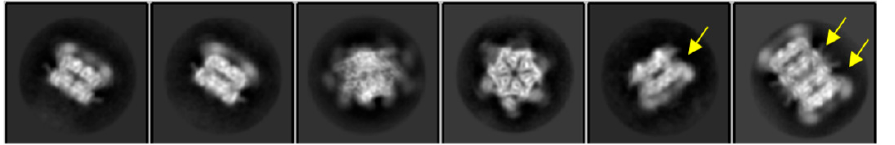
Figure 2. Two-dimensional (2D) class averages of cryo-EM particle images show the compositional heterogeneity. p97 R155H mutant complex [55]. Box side length is 374 Å. Yellow arrows indicate one single protein complex.